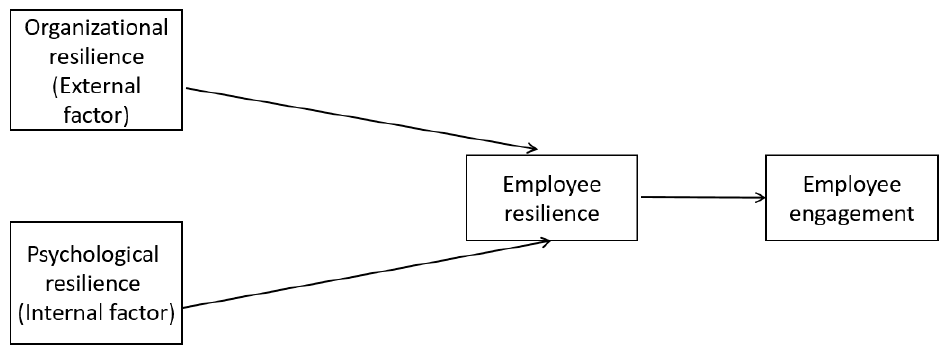
Figure 1. Basic research model (Source: authors).